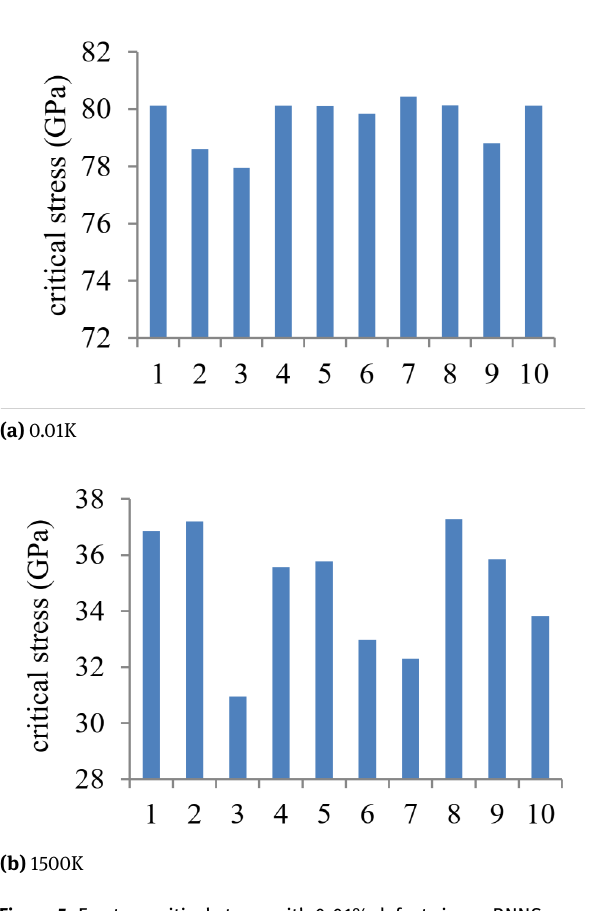
Figure 5: Fracture critical stress with 0.01% defect zigzag BNNS.